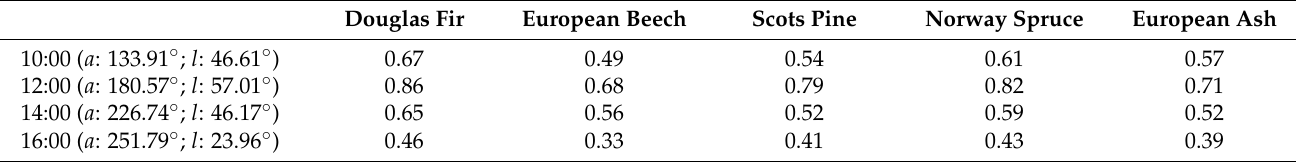
Table 5. Light transmittance of five tree species in the emulated mixed plot at different times with corresponding solar azimuth angle a and altitude angle l , i.e., 10:00 ( a : 133.91 ◦ ; l : 46.61 ◦ ), 12:00 ( a : 180.57 ◦ ; l : 57.01 ◦ ), 14:00 ( a : 226.74 ◦ ; l : 46.17 ◦ ), and 16:00 ( a : 251.79 ◦ ; l : 23.96 ◦ ), on 10 September 2022 in